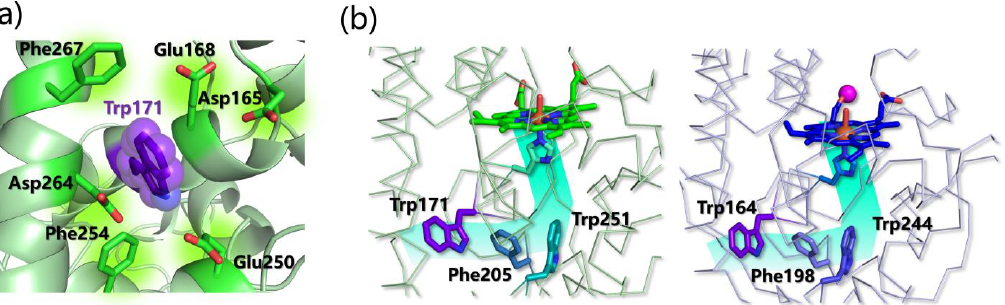
Figure 11. ( a ) Representation of the conserved residues surrounding the catalytically active trypto- phan in LiPs (PDB: 1B82 from P. chrysosporium ). ( b ) Residues involved in the LRET path in LiP (right, PDB: 1B82 from P. chrysosporium ) and VP (left, PDB: 2BOQ from P. eryngii ).